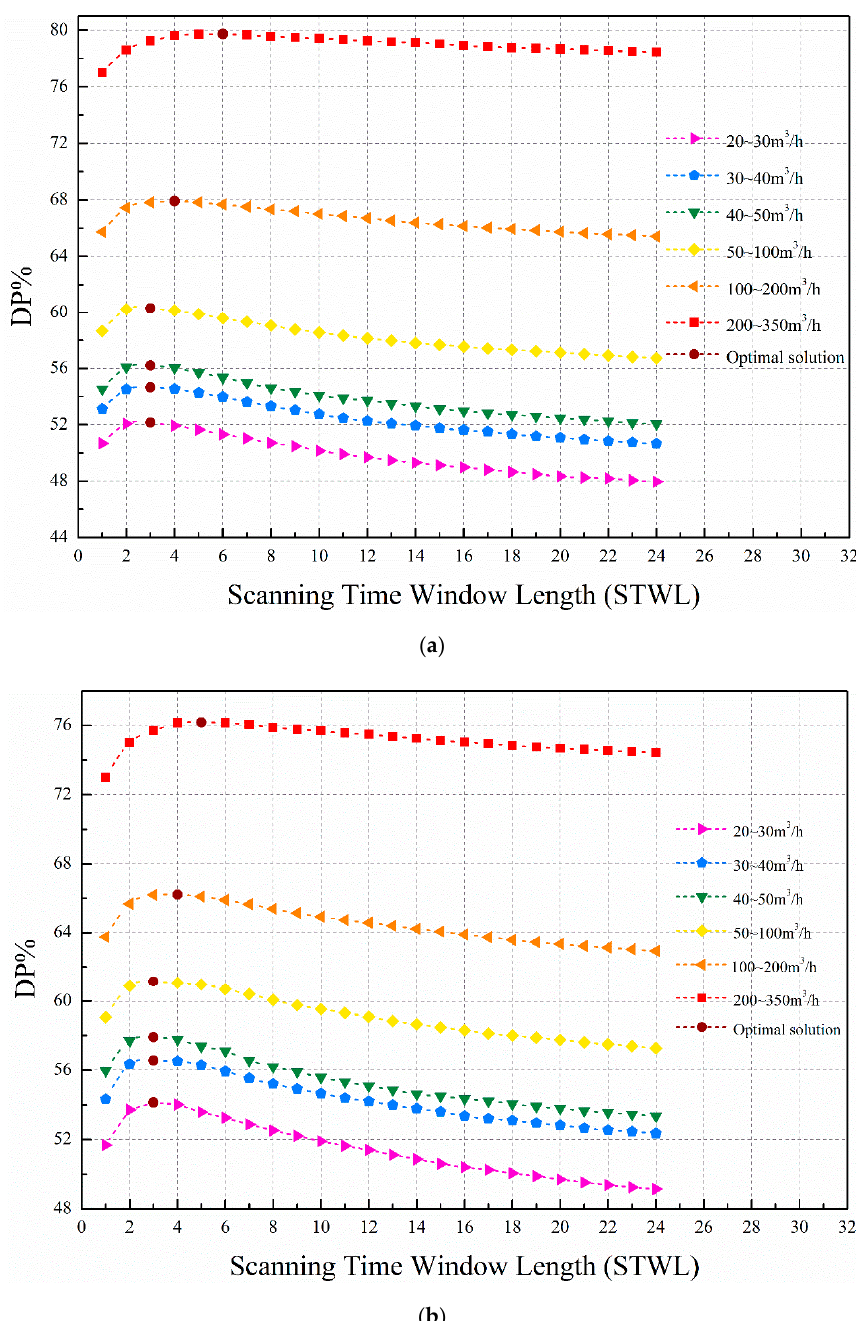
Figure 8. Leakage detection probability for different flow rate intervals when CRF = 10%: ( a ) σ = 0.2 m, p = 5%; ( b ) σ = 0.2m, p = 10%.